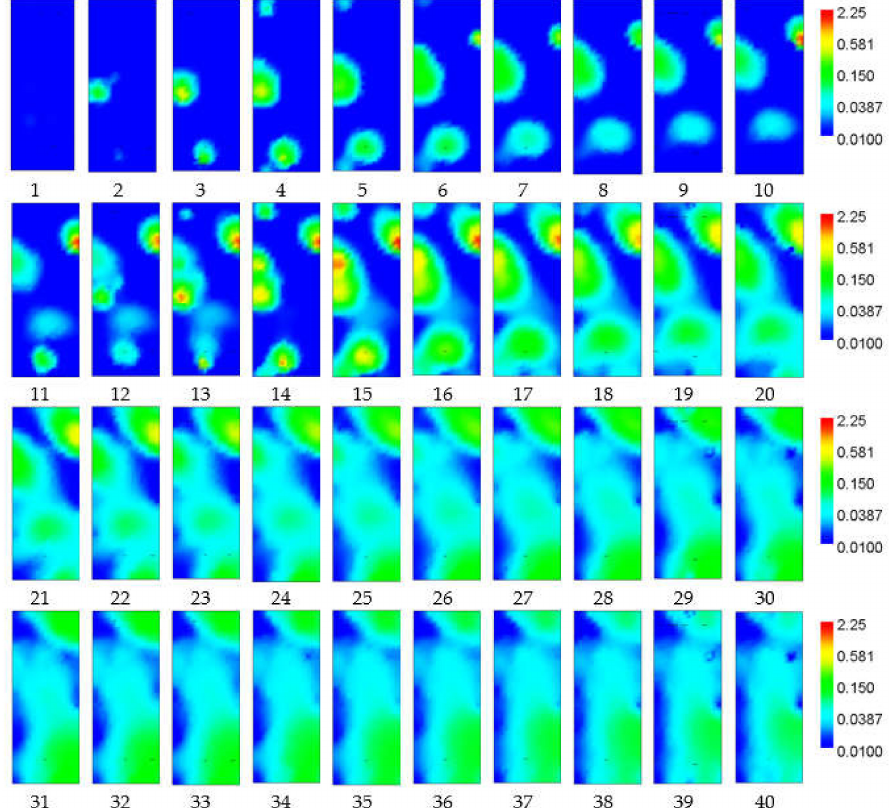
Figure 13. The spatial pattern of the atrazine concentration ( µ g / L) in the aquifer from year 1 to year 40 (a logarithmic color